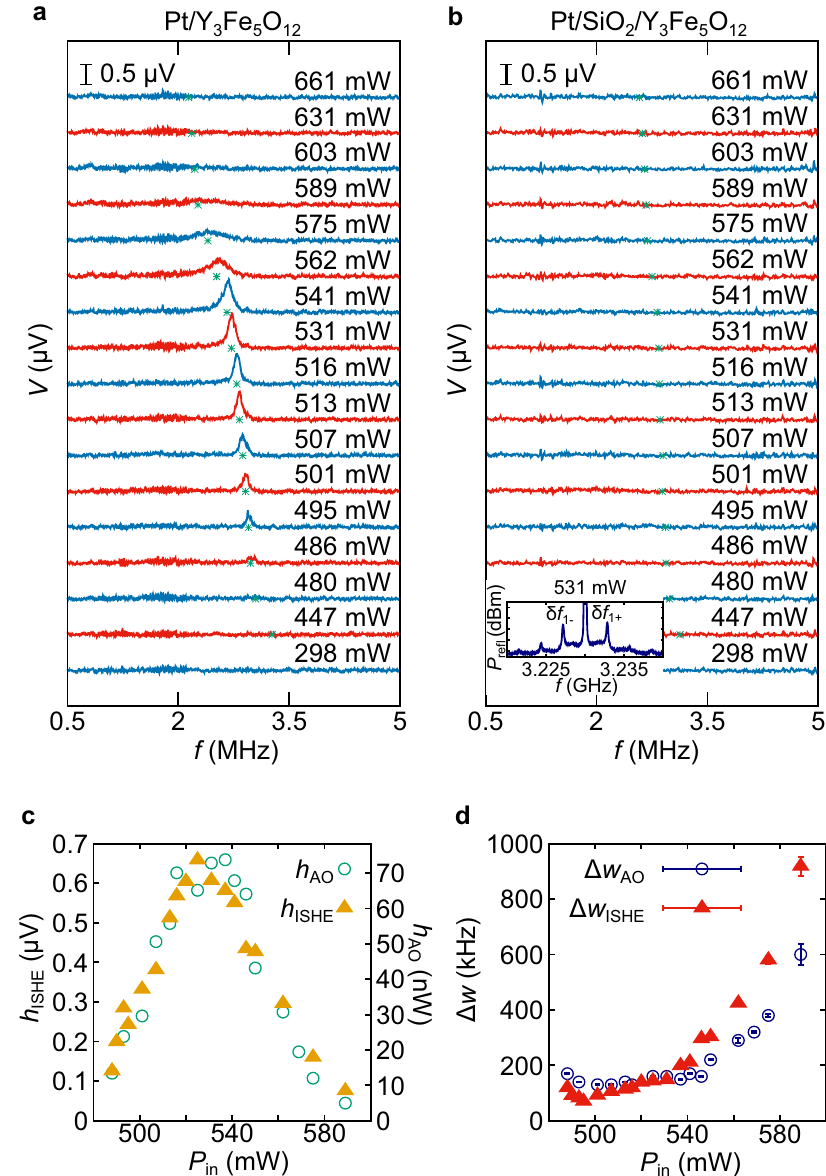
Figure 3. AO-induced spin currents in MHz-band. ( a , b ) Frequency dependence of V in the MHz range in Pt/ Y 3 Fe 5 O 12 ( a ) and Pt/SiO 2 /Y 3 Fe 5 O 12 ( b ) at various values of P in . Green points indicate frequencies of the AO, δ f 1 + , at each P in (see Fig. 2d). The inset to ( b ) shows the P refl spectrum for the Pt/SiO 2 /Y 3 Fe 5 O 12 film at P in = 531 mW. The incident microwave frequency was 3.23 GHz. H was set at 545 Oe. ( c ) P in dependence of the peak height h AO of the GHz AO sidepeak at δ f 1 + ( h AO ) and the MHz-band voltage peak ( h ISHE ), measured in the Pt/Y 3 Fe 5 O 12 film ( a ). ( d ) P in dependence of the half width of the peak at δ f 1 + for the GHz AO sidepeak, Δ w AO , (Fig. 2d) and the MHz-band voltage peak, Δ w ISHE , ( a